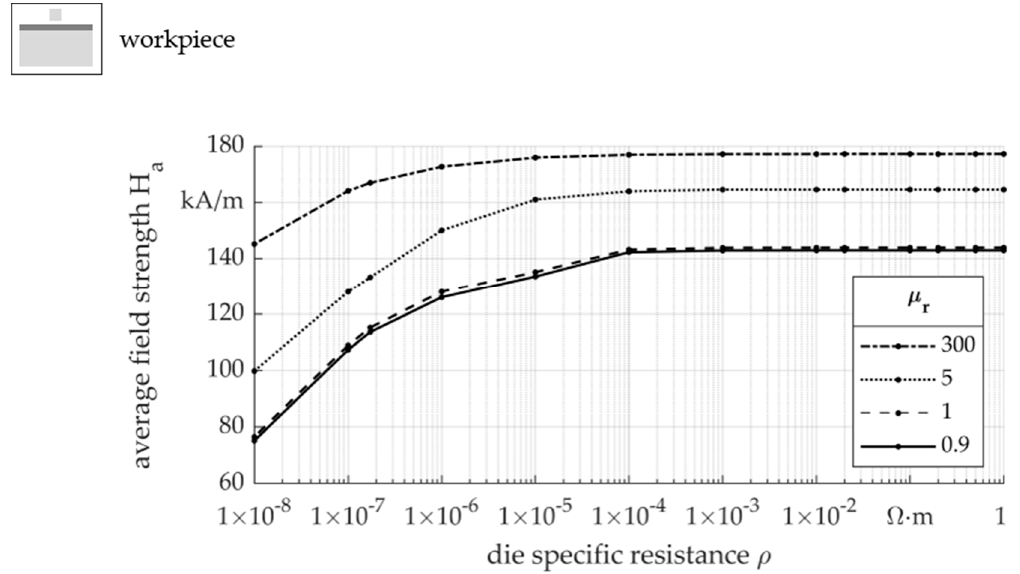
Figure 12. Average magnetic field strength H a in the workpiece in respect of the specific resistance 𝜌 of the die material.